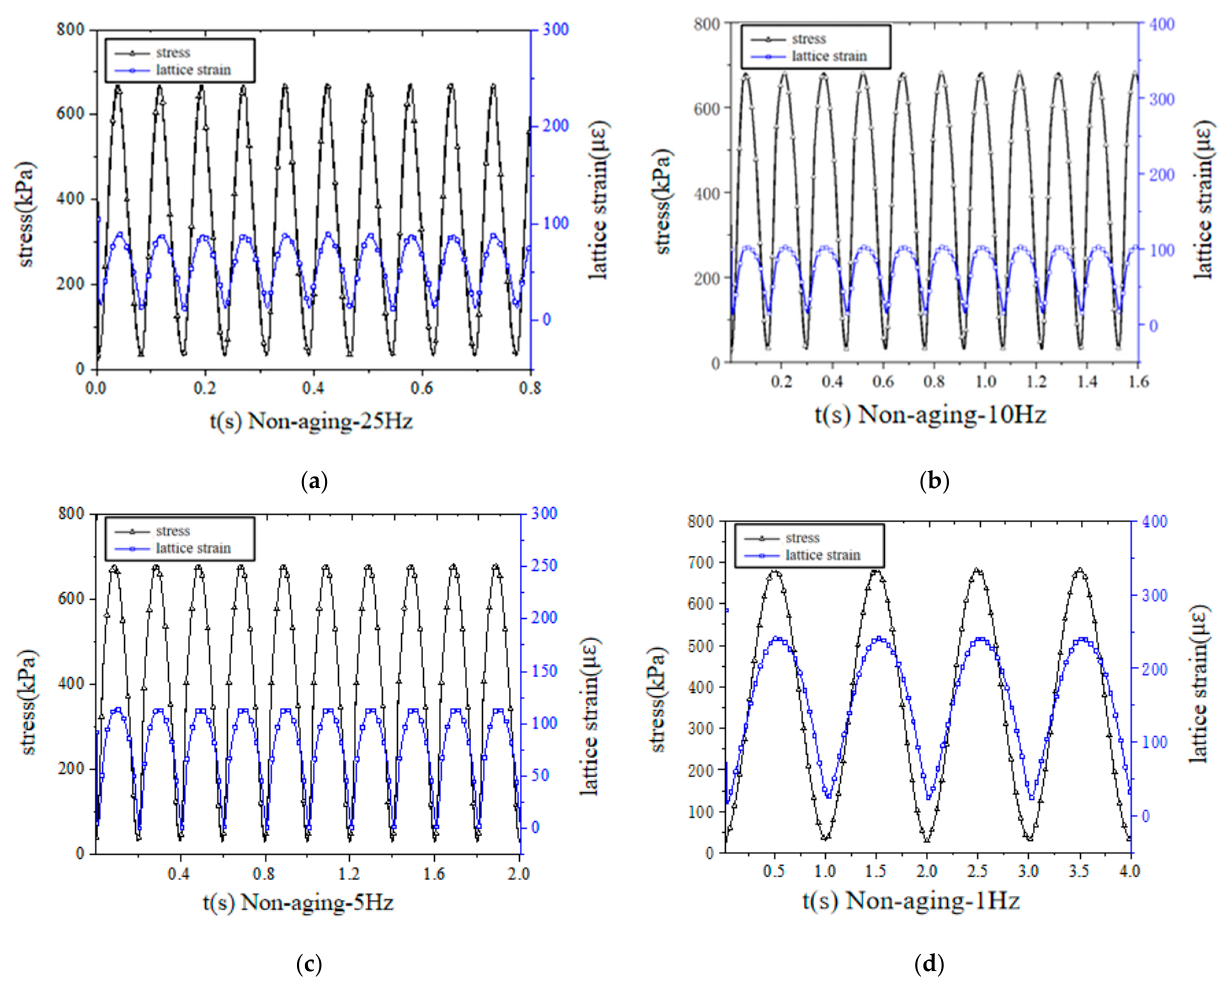
Figure 16. DEM simulation of the stress and strain curves of unaged mixtures under frequencies of ( a ) 25 Hz, ( b ) 10 Hz, ( c ) 5 Hz and ( d ) 1 Hz. Table 8. Dynamic modulus value of DEM simulation experiment of the asphalt mixture under different aging conditions.